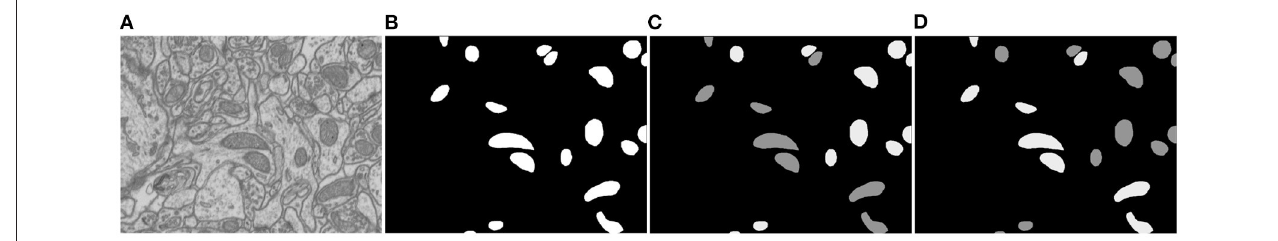
FIGURE 4 | Illustration of the proposed soft label-decomposition. A ground truth label map Y in the training data is decomposed into two complementary label maps Y 1 and Y 2 according to roundness of each mitochondrion instance. All the three label maps are jointly used to supervise the model training. (A) EM image, (B) full label map Y , (C) circular label map Y 1 , (D) oval label map Y 2